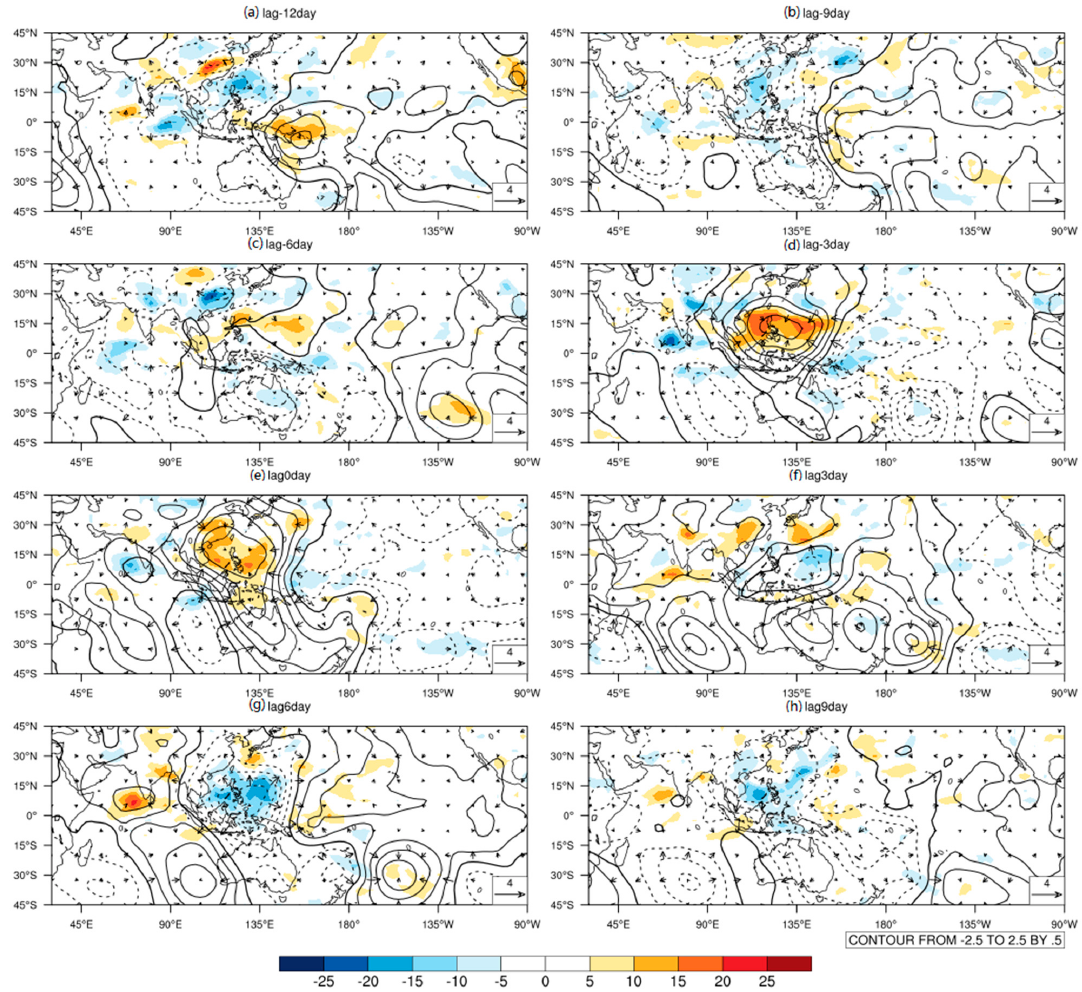
Figure 8. Composite horizontal spatial-temporal evolutions of 10-to-30-day OLR anomalies (shading, W m − 2 ) and (200 hPa–850 hPa) velocity potential anomalies {contours (dashed: negative, solid: positive), CI: 0.5 10 6 m 2 s − 1 } along with (200 hPa–850 hPa) divergent wind anomalies (vectors, m s − 1 ) of all EHW events on lag days of − 12 ( a ), − 9 ( b ), − 6 ( c ), − 3 ( d ), 0 ( e ), 3 ( f ), 6 ( g ), 9 ( h ).